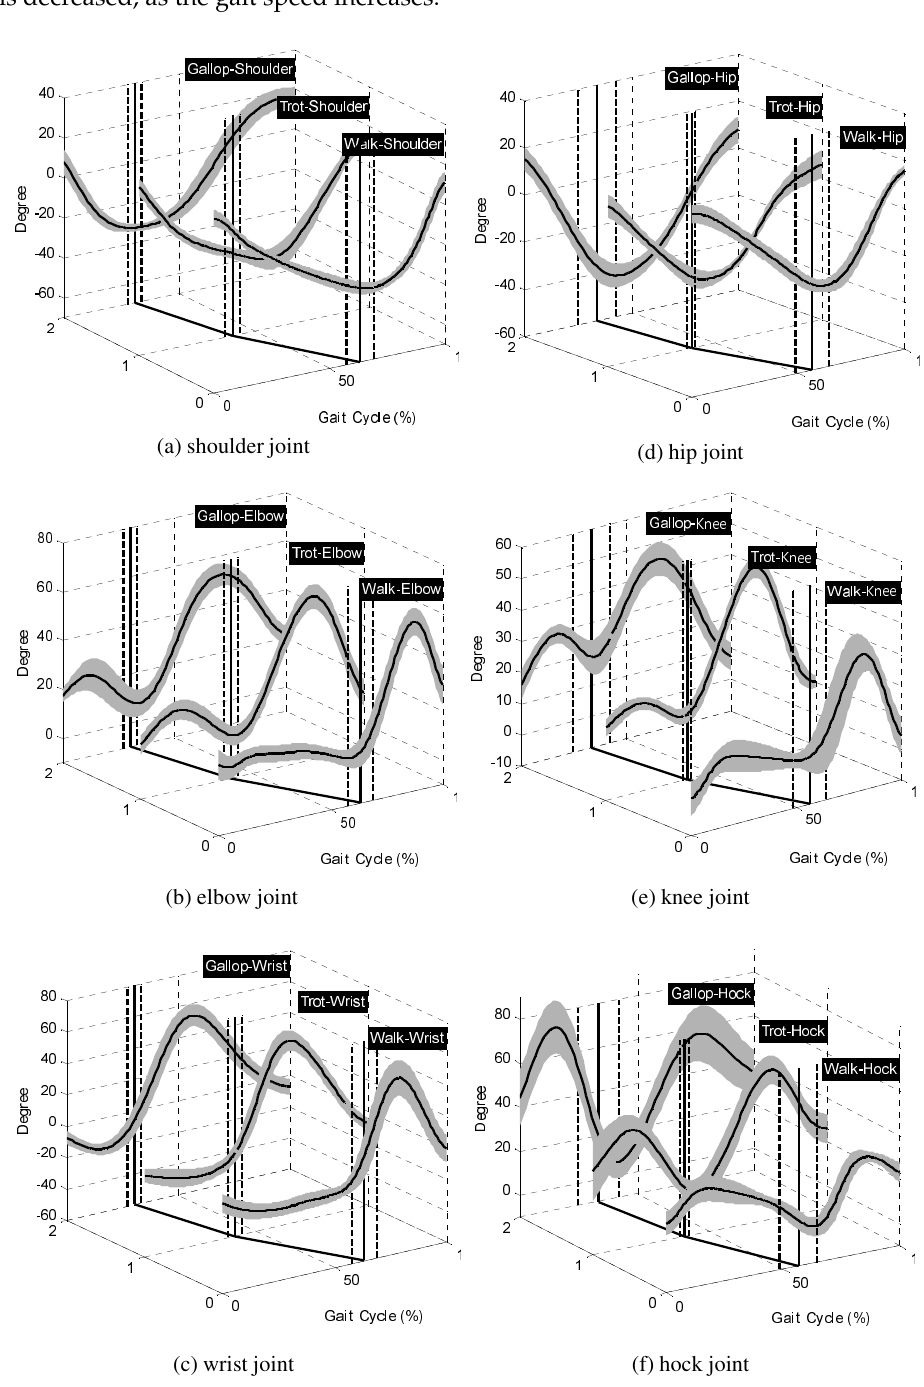
Figure 3. Joint-angle trajectories of a dog in multiple gait phases: ( a ) the shoulder joint-angle, ( b ) the elbow joint-angle, ( c ) the wrist joint-angle, ( d ) the hip joint-angle, ( e ) the knee joint-angle, and ( f ) the hock joint-angle. The black continuous lines and the gray bands represent the mean values and the standard deviation of measurements, respectively. The numbers in the y -axis mean 0: walk phase, 1: trot phase, and 2: gallop